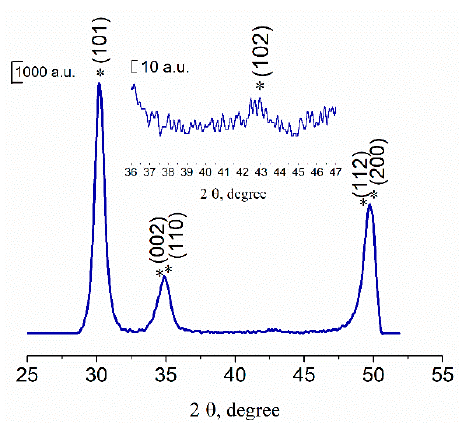
Figure 2. XRD data of pure 3Y-TZP-Al 2 O 3 powder (composition I), where * is t-ZrO 2 .